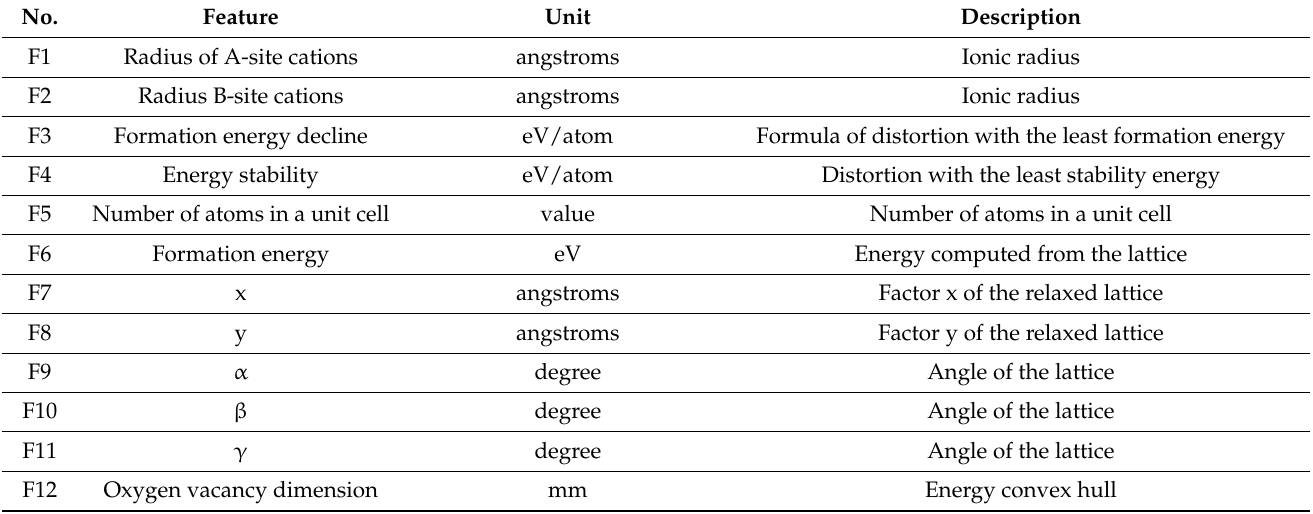
Figure 2. Workflow and data preparation. Table 2. Representative performance factors of the perovskite